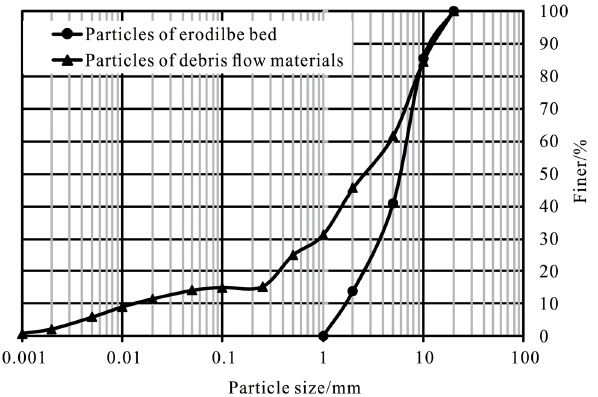
Figure 3. The particle size distribution of samples for the debris flows and erodible